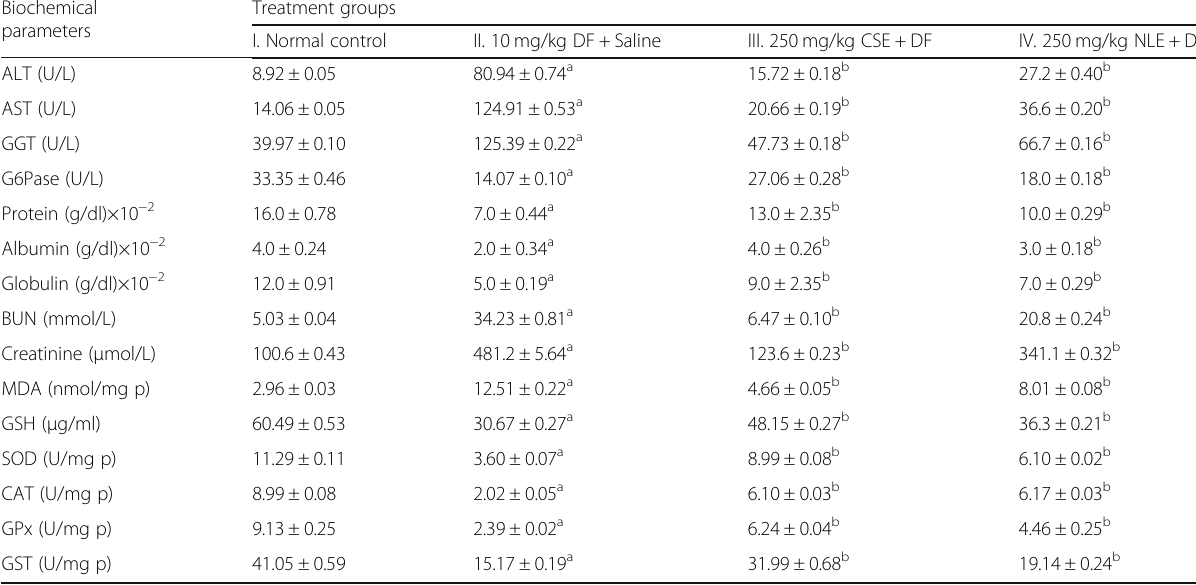
Table 4 Effect of CSE and NLE on serum markers of hepatorenal oxidative damage in DF-exposed rats Biochemical